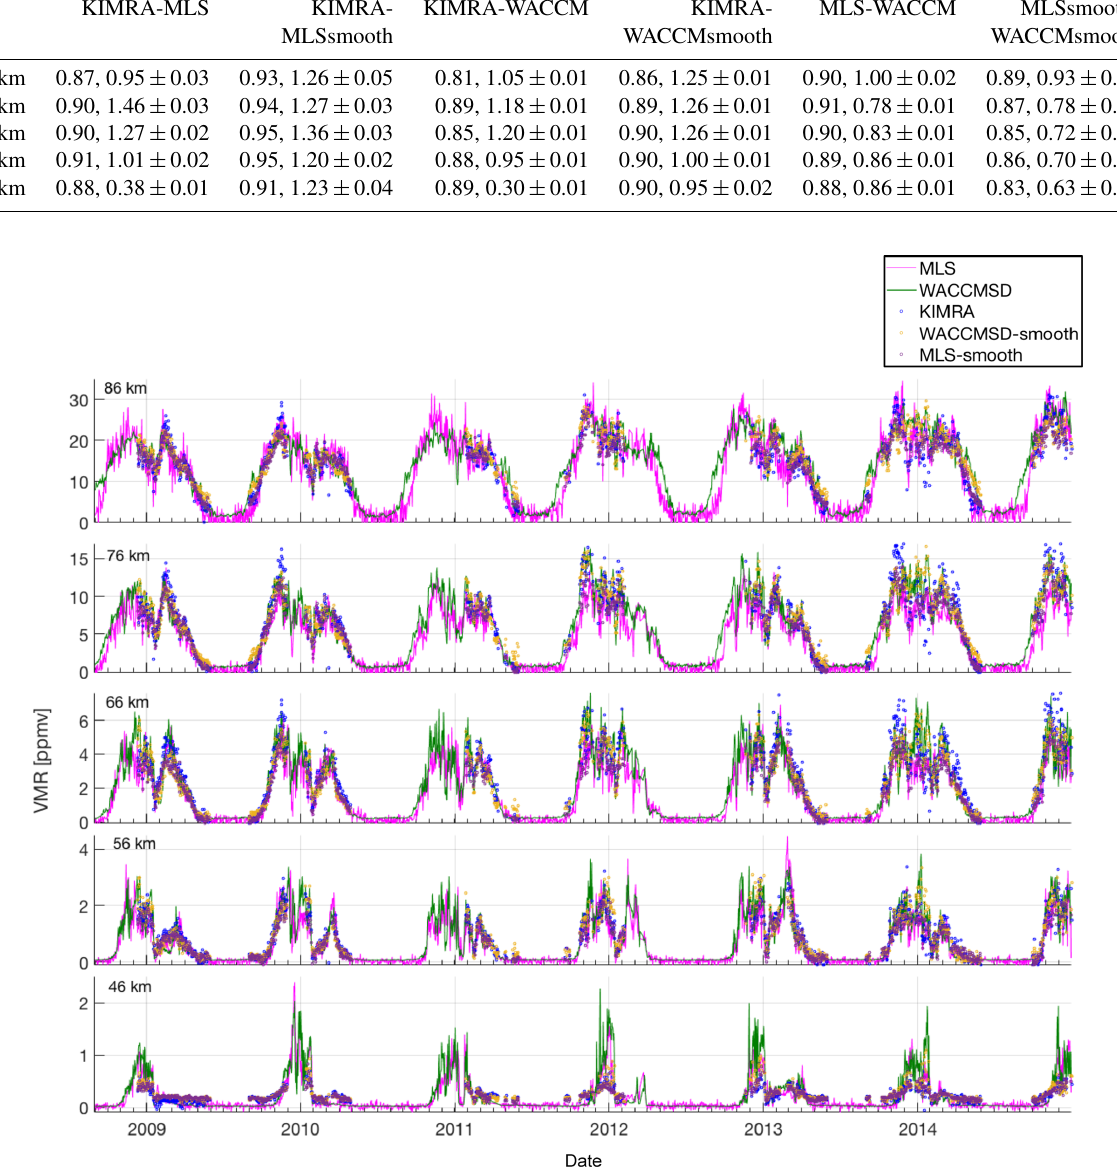
Figure 1. Comparisons of daily CO VMRs from KIMRA, MLS, and SD-WACCM above Kiruna for 2008 through 2014. Values are displayed at 46, 56, 66, 76, and 86km altitude. Correlation and regression coefficients for the datasets are given in Table 2. See Sect. 2.4 for details.